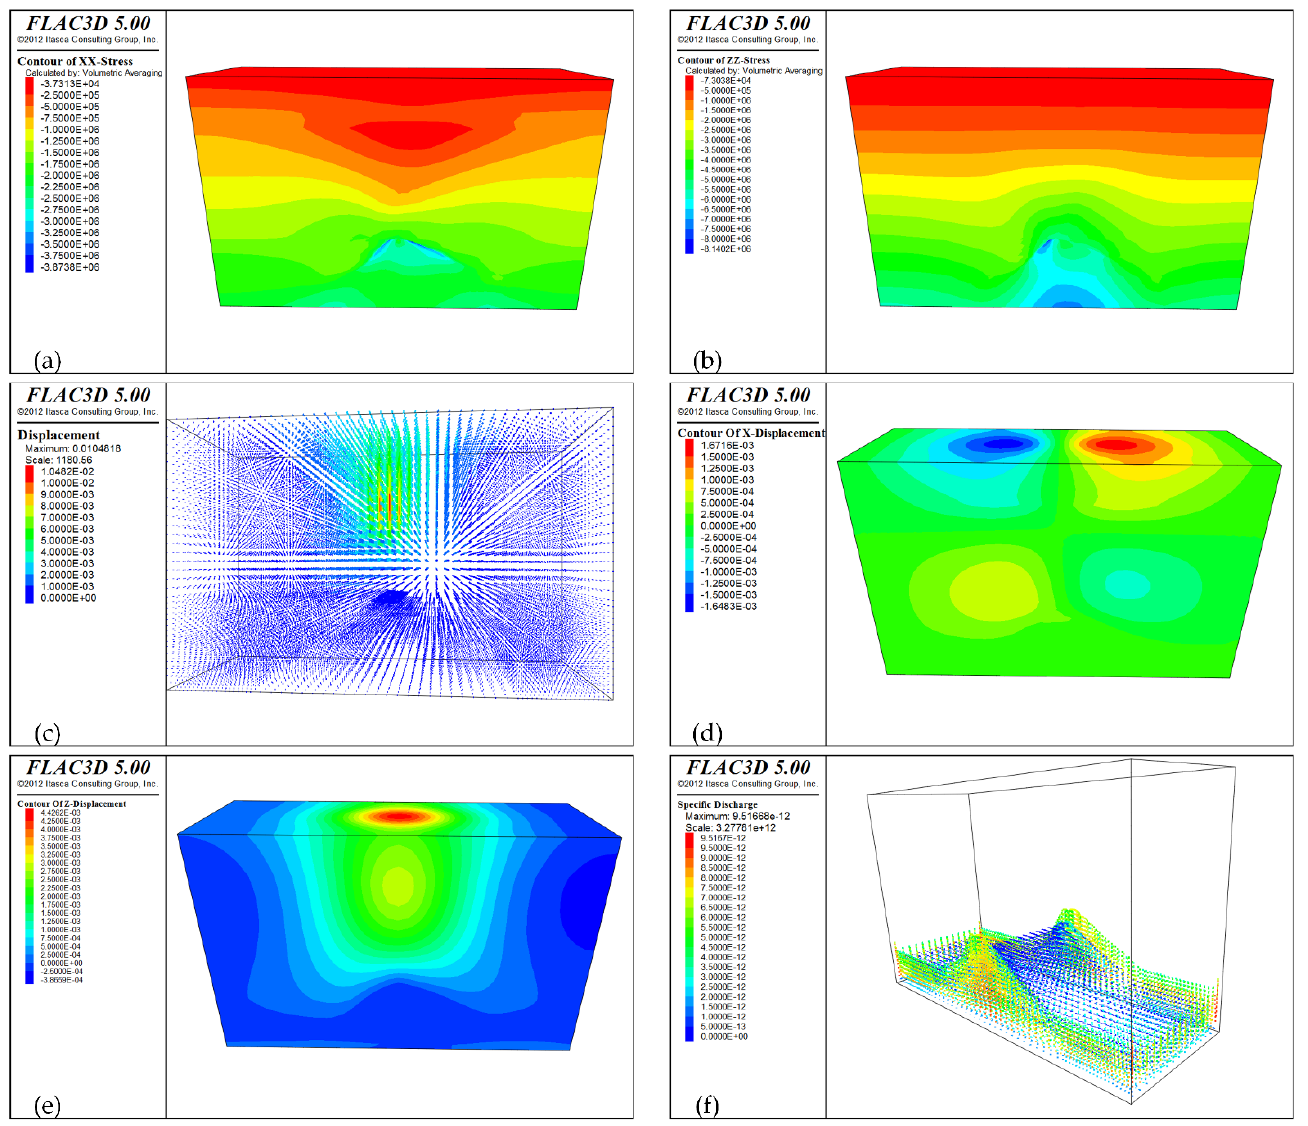
Figure 12. Distribution of stress field, deformation field, and seepage field after pumping. ( a ) Stress field distribution (x direction). ( b ) Stress field distribution (z direction). ( c ) Total displacement. ( d ) Displacement field distribution (x direction). ( e ) Displacement field distribution (Z direction). ( f ) Pumping seepage field.